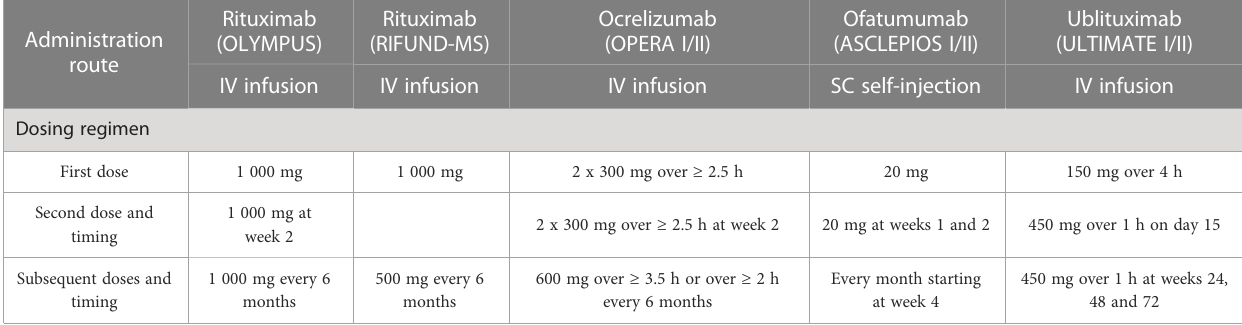
TABLE 1 Administration route and dosing regimens of anti-CD20 mAbs in phase II/III clinical trials.